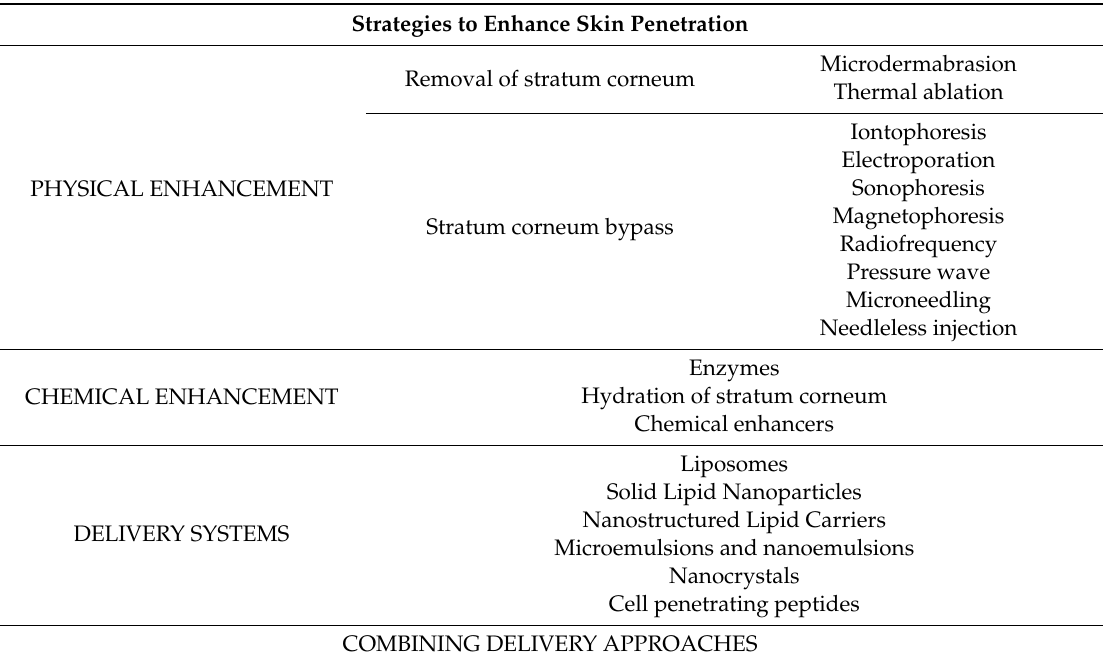
Table 1. Strategies to enhance skin